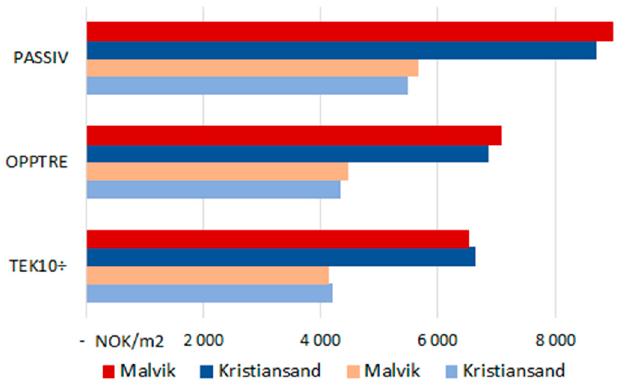
Figure A1. Specific cost of envelope upgrading. Pale colors show the cost with the discounted residual value subtracted.